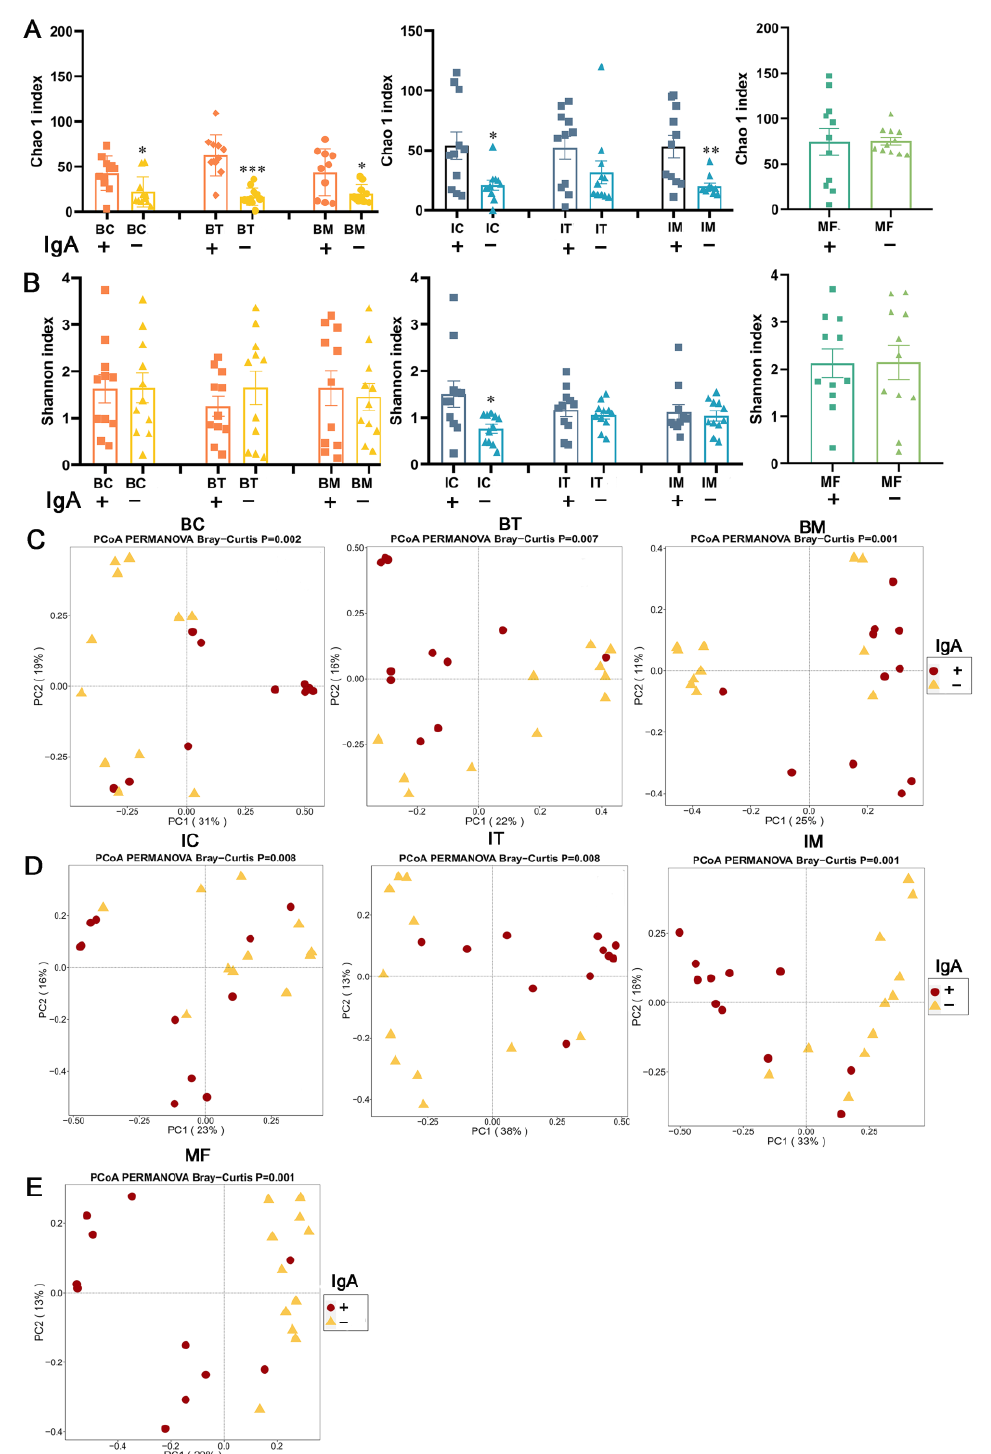
Figure 4. Comparison of diversity between sIgA-coated and -uncoated bacteria in HBM, infant feces and maternal feces. ( A , B ) Alpha diversity. ( C – E ), Beta diversity The Bray–Curtis distance was utilized to calculate the difference between samples using PERMANOVA. *, p < 0.05; **, p < 0.01; ***, p < 0.001; three stages of infant feces compared to corresponding HBM. BC, BT, BM, IC, IT, and IM stand for colostrum, transitional milk, mature milk, and infant feces corresponding to HBM stages. / means unsorted bacteria, IgA+ means IgA-coated bacteria, and IgA − means IgA-uncoated